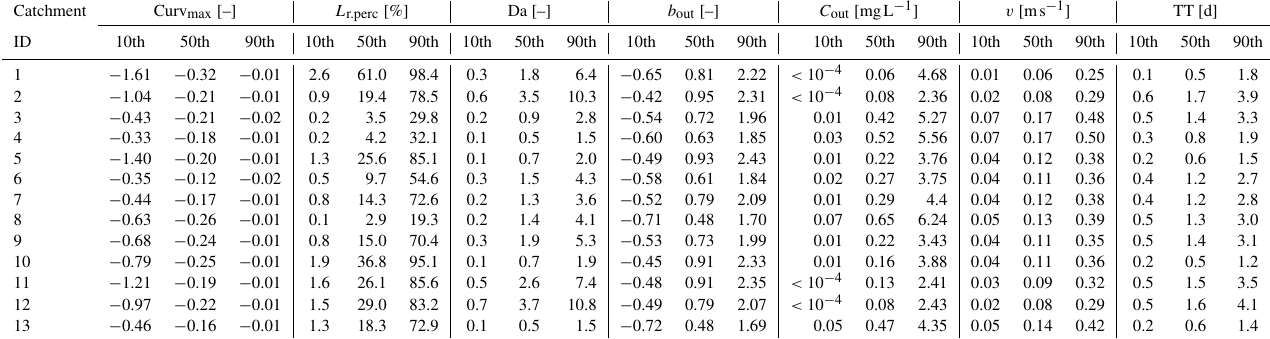
Table 4. The 10th, 50th and 90th quantiles of model outputs Curv max , percentage of load removed, ( L r.perc ) Damköhler number (Da), regression slope of the log (C) –log (Q) relationship at the basin outlet ( b out ), the median concentration at the basin outlet ( C out ), the median water velocity ( v ) and median river network travel times (TT) for each of the 13 German catchments. Catchment Curv max